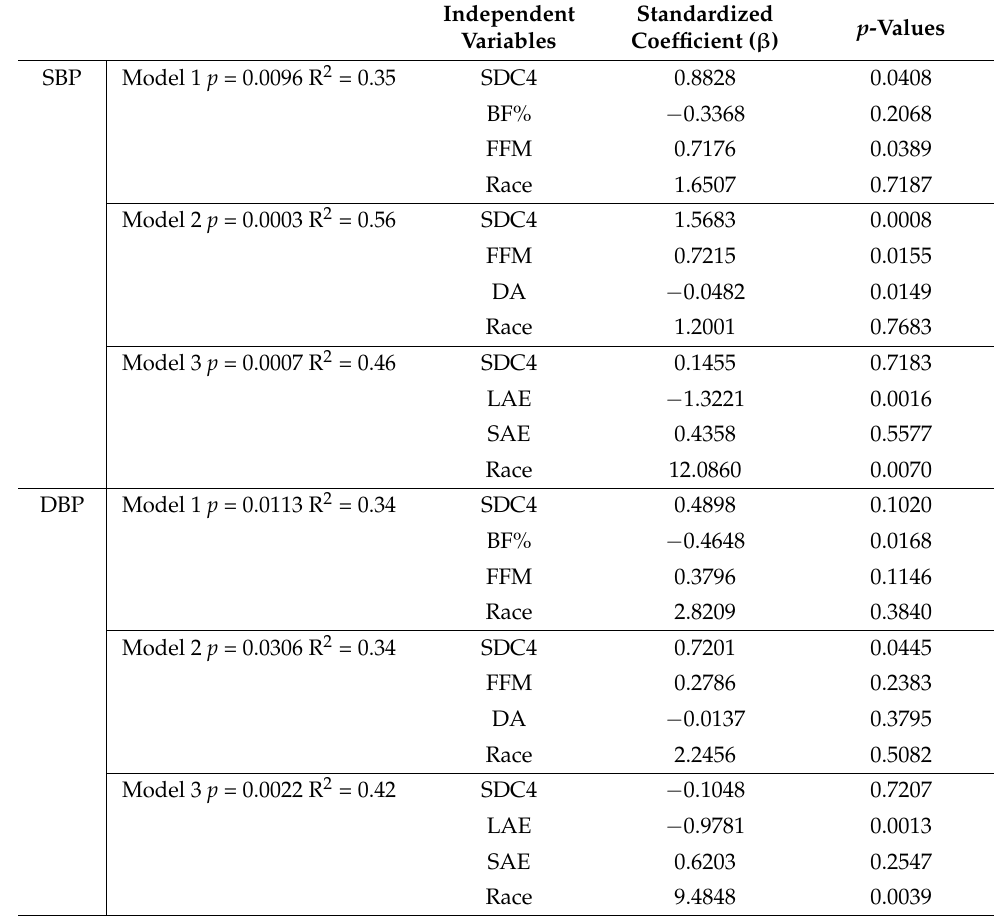
Table 3. Multiple linear regression models for associations of SDC4 levels with SBP and DBP. Independent